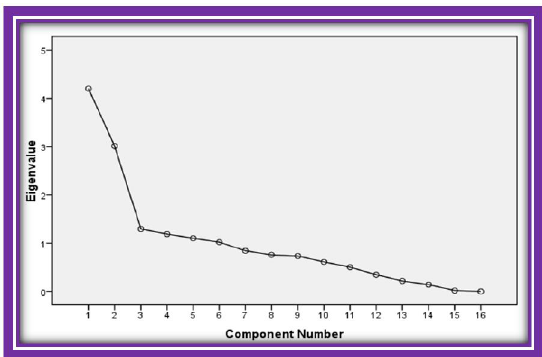
Fig. 1. The summary of Scree plot